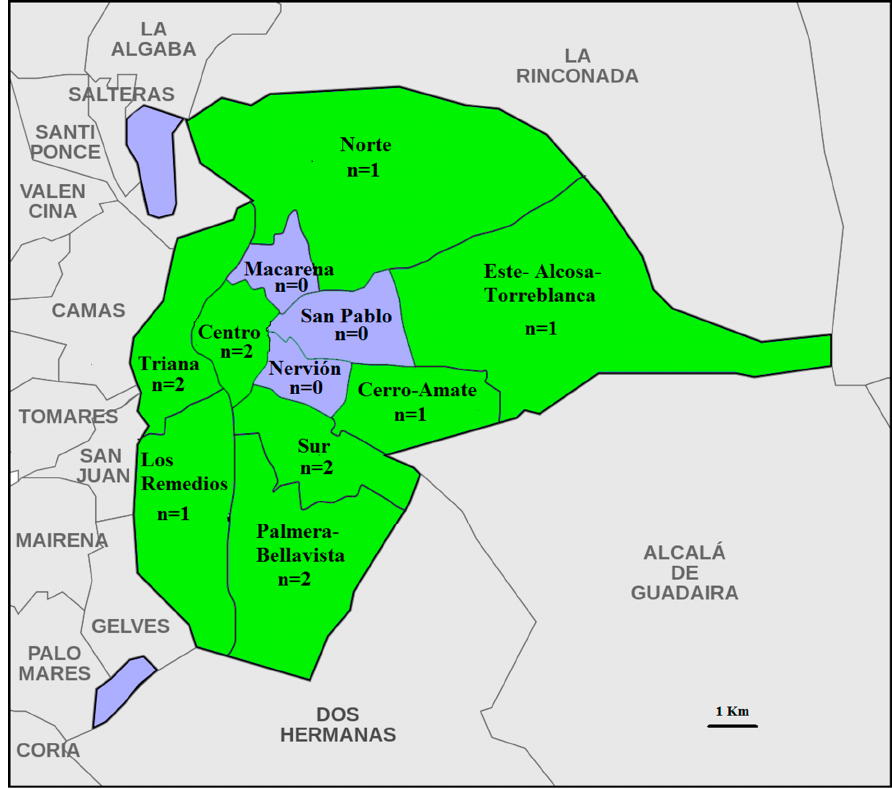
Figure 1. Sampled districts of Seville. Districts not sampled are blue, while sampled districts are green; “n” shows the number of locations sampled per district. To collect the mites, the nasal cavities were opened under an Olympus binocular ste- reo microscope with a scalpel and small scissors. First, the ossa mandibulae was removed